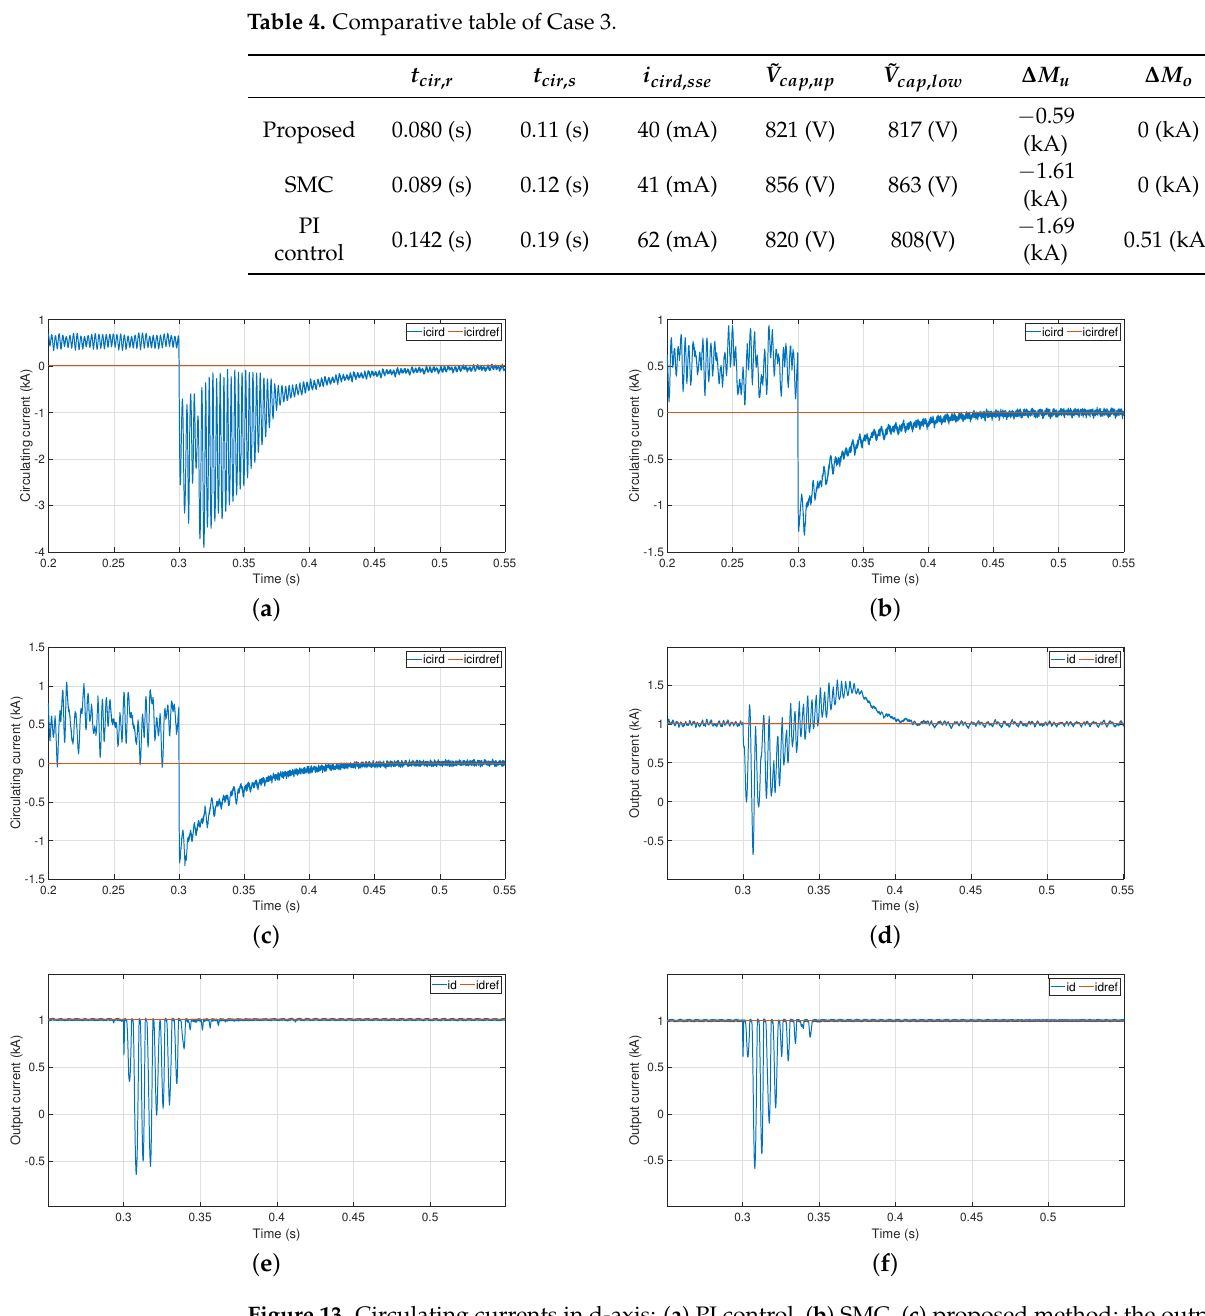
Figure 13. Circulating currents in d-axis: ( a ) PI control, ( b ) SMC, ( c ) proposed method; the output current in d-axis: ( d ) PI control, ( e ) SMC, ( f ) proposed